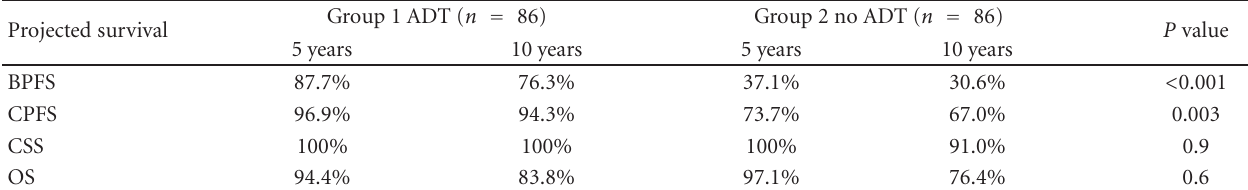
Table 2: Freedom from biochemical progression free-survival (BPFS), clinical progression-free (CPFS), cancer-specific (CSS), and overall survival (OS).